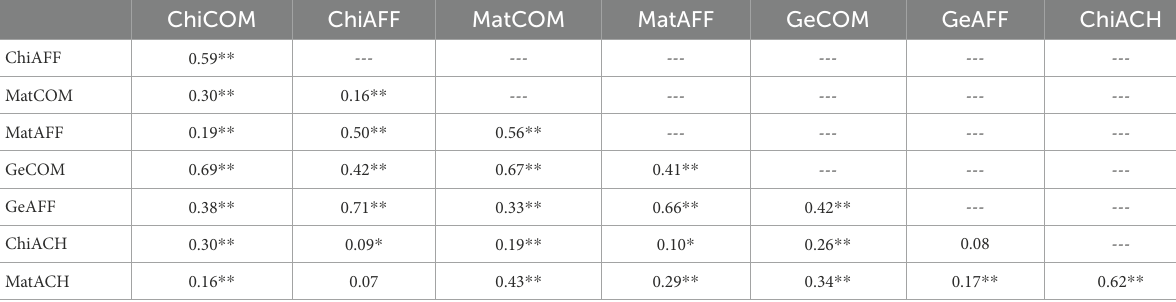
TABLE 6 Factor correlations at T3.